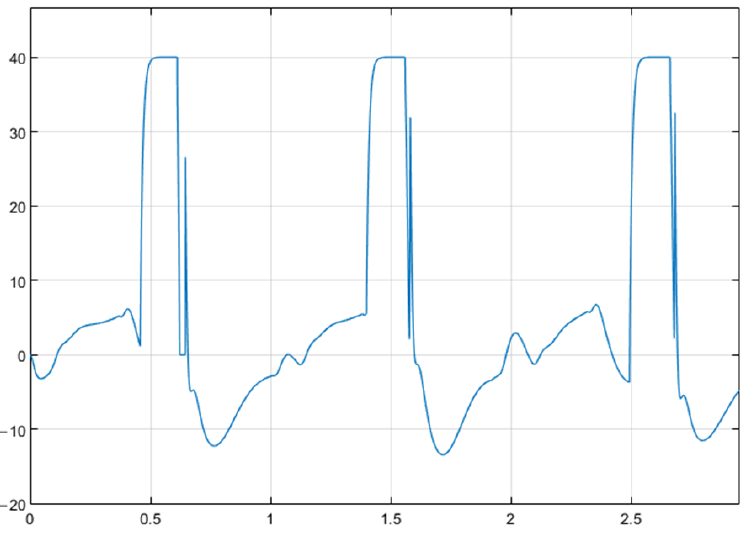
Figure 17. Hip torque